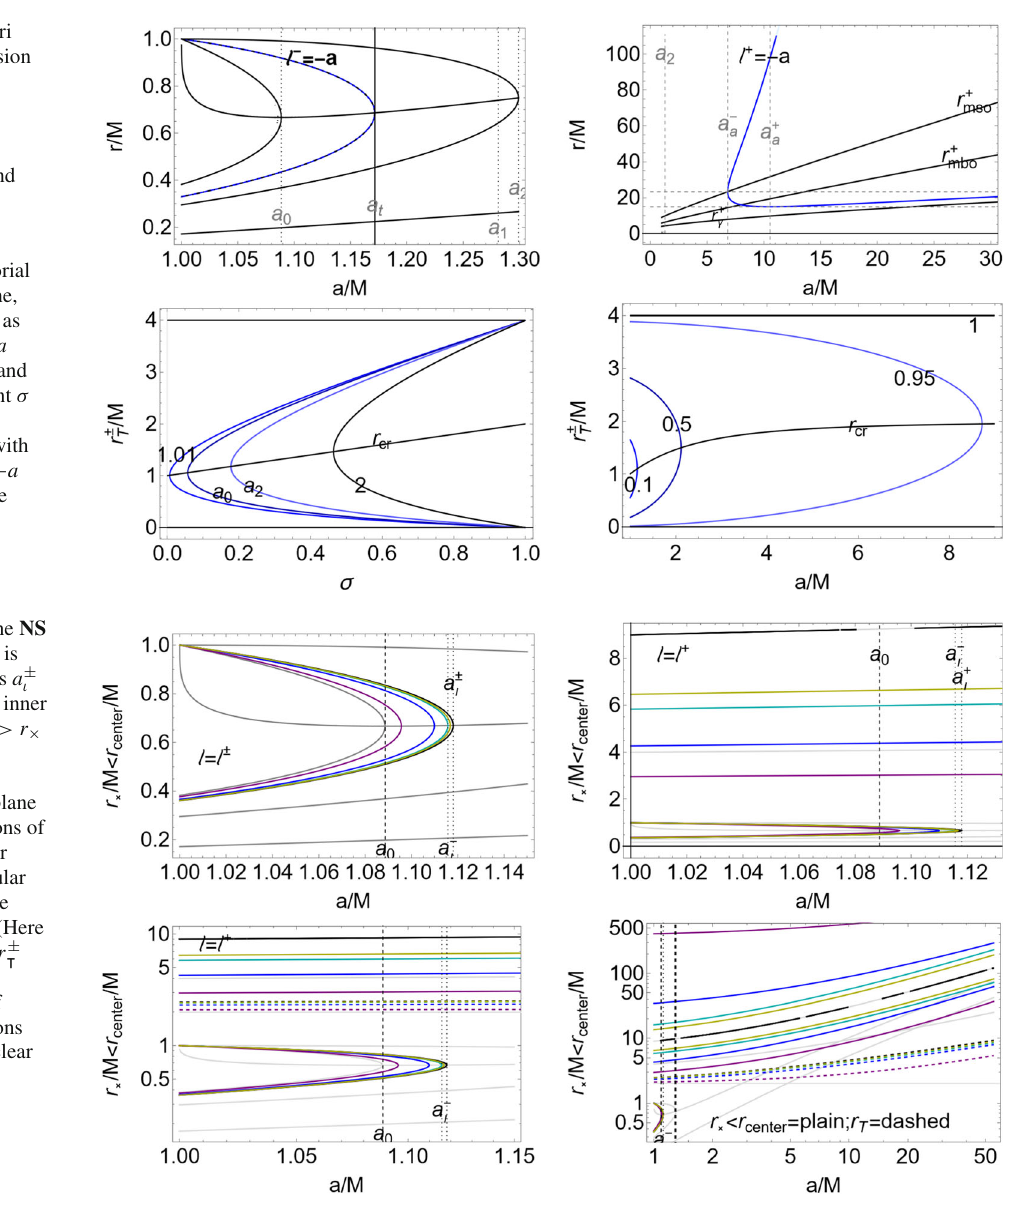
Fig. 18 Analysis of the tori (upper line) and flow inversion points (bottom line) with (cid:6) = − a . There is (cid:18) (cid:19) √ a t ≡ 2 M , 2 − 2 (cid:18) √ (cid:19) √ a + a ≡ 2 M and 2 3 + 2 (cid:18) √ (cid:19) M – see a − a ≡ 2 2 + 2 Eq. (13). There is σ = sin 2 θ ∈ [ 0 , 1 ] (equatorial plane is σ = 1). Bottom line, inversion radius at (cid:6) = − a as function of σ for different a signed on the curves (left) and as function of a for different σ (right). Upper line: critical points of pressure for tori with (cid:6) − = − a (left) and (cid:6) + = − a (right). Black curves are the geodesic structures. Spins